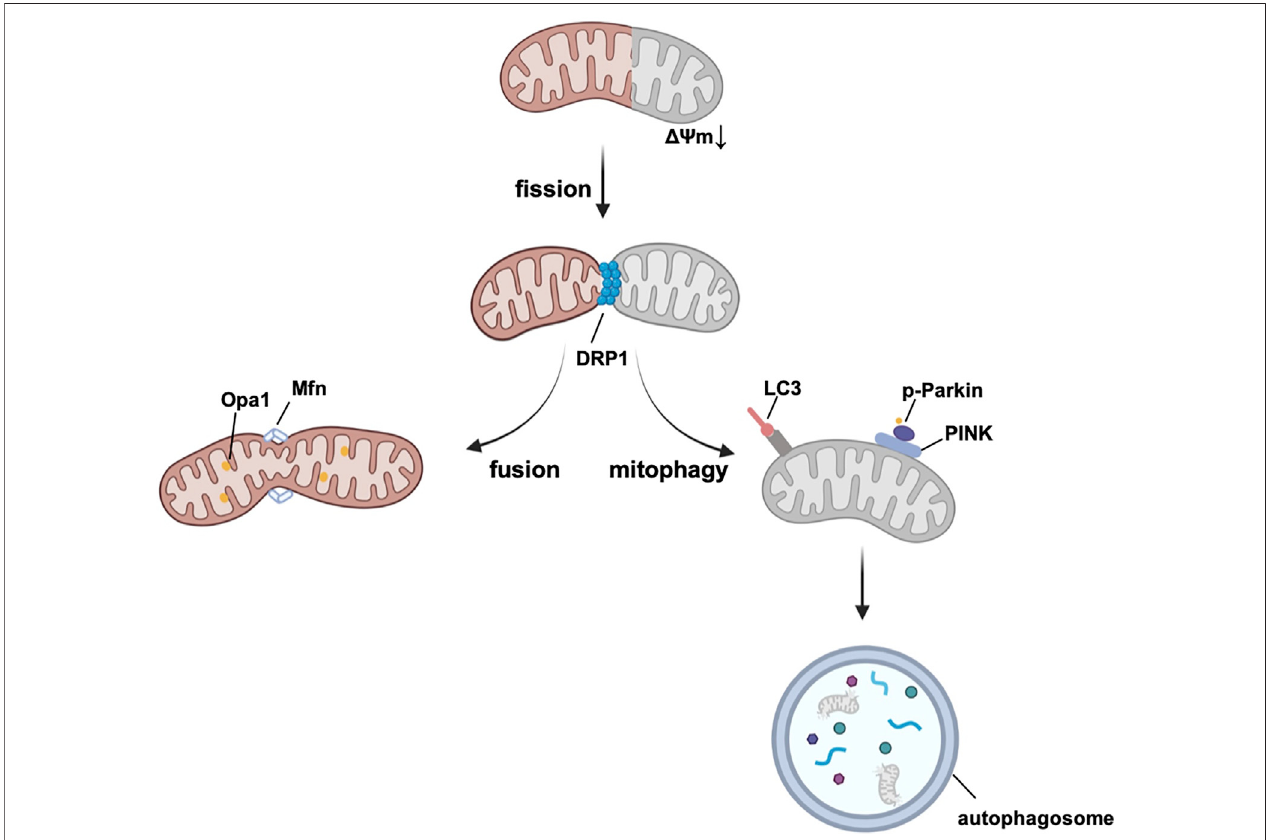
FIGURE 3 | Mitochondrial quality control system. Damaged mitochondrial fragment splits from healthy mitochondrion by fi ssion and then degrades by mitophagy. Mitochondrial fusion assembles healthy mitochondria and maintains the normal function of mitochondria. Abbreviations: Opa1, optic atrophy 1, Mfn, mitofusin, DRP1, Dynamin-related protein 1, LC3, microtubule-associated protein 1A/1B-light chain 3, PINK, PTEN-induced kinase 1, Δψ m, mitochondrial membrane potential.